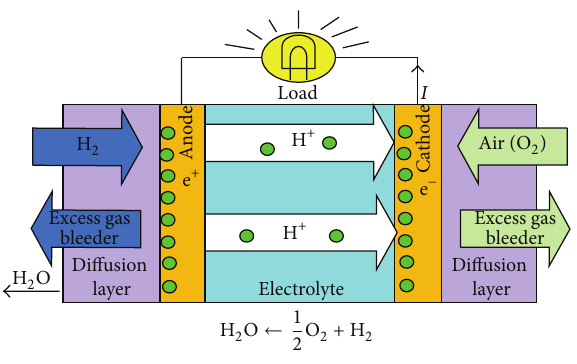
Figure 1: FC power generation process.